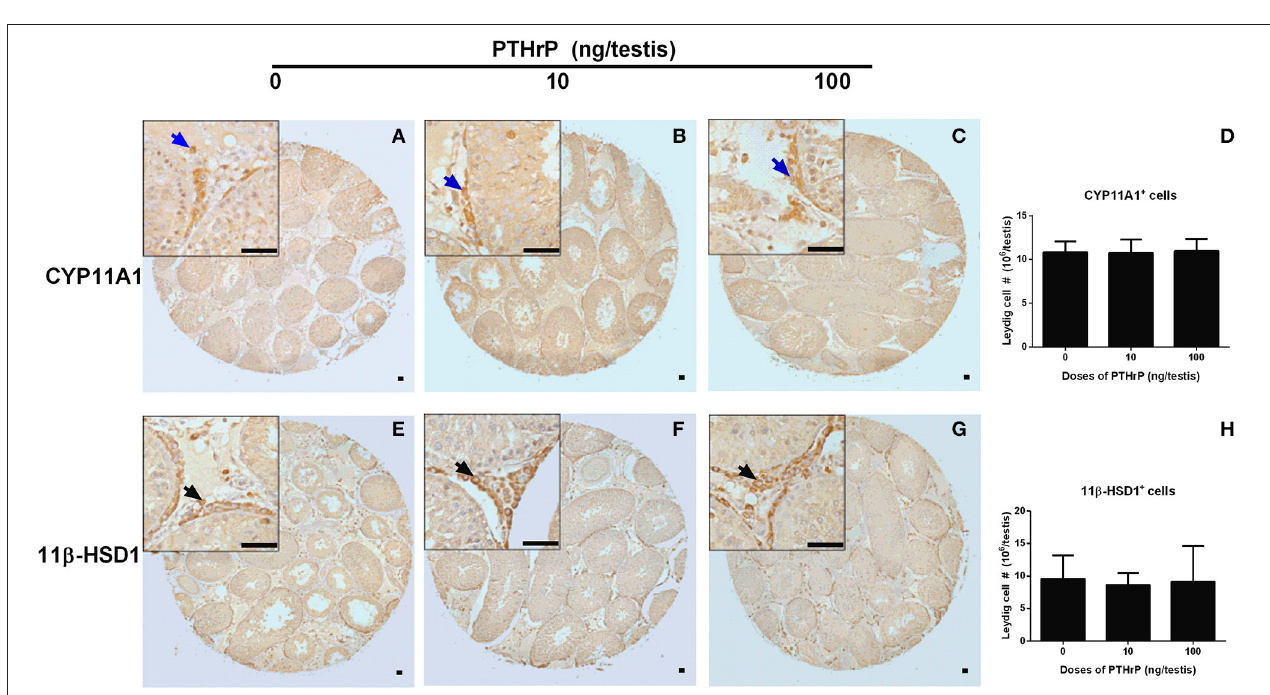
FIGURE 5 | Effects of PTHrP on cell, nuclear, and cytoplasmic sizes of Leydig cells in the testes after in vivo treatment. Immunohistochemical staining of CYP11A1 of the testes from the rats treated with 0, 10, and 100ng/testis PTHrP on post-EDS day 7 for 21 days. (A–C): cell, nuclear, cytoplasmic size, respectively. Mean ± SEM, n = 6. * P < 0.05, ** P < 0.01 when compared to the control.